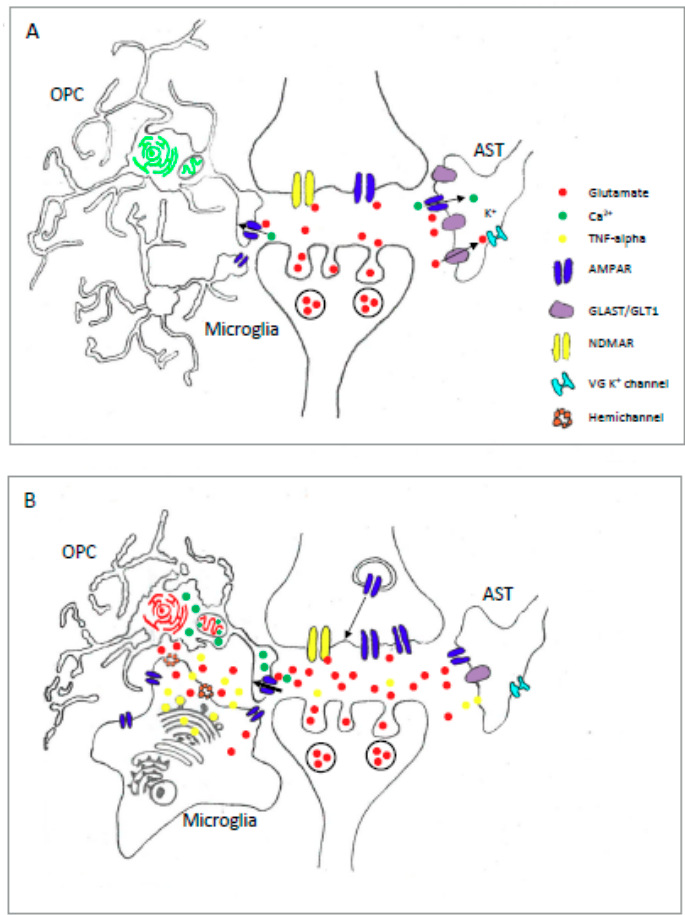
Figure 2. AMPAR functions for peri-synaptic CNS glia in health and disease. ( A ) In the healthy CNS astrocyte (AST) and OPC / NG2-glia processes exhibit physical and functional contacts with neuronal synapses. Ca 2+ permeable AMPAR on Bergmann glia sustain the physical interaction between glial processes and neuronal synapses allowing e ffi cient clearance of glutamate from Purkinje cell synapses. Activation of astrocyte AMPAR also induces a blockade of outward K + currents that may support neuronal function during sustained periods of neuronal activity. OPC / NG2-glia in developing and adult CNS tissues exhibit Ca 2 + permeable AMPAR and receive AMPAR-mediated synaptic input that may regulate their migration, maturation and survival. In the adult CNS NG2-glia continue to receive synaptic input, the functions of which remain unclear. The role of microglial AMPAR in the healthy CNS remain unknown although in vitro data suggest a role in chemotaxis [117]. ( B ) Glial cell AMPAR amplify pathological conditions and mediate glial cell injury in the CNS. Stimulation of AMPAR under excitotoxic conditions induces the release of glutamate from activated microglia via gap-junction hemichannels. AMPAR activation under hypoxic conditions also stimulates the upregulation of microglial AMPAR leading to an imbalance in anti- and pro-inflammatory cytokine release characterised by enhanced release of TNF- α . TNF- α released from activated microglia may intensify excitotoxic conditions by inducing the downregulation of astrocytic GLT1. Similarly, direct stimulation of astrocyte AMPAR may worsen excitotoxic conditions by inducing the downregulation of GLAST. TNF- α also increases the vulnerability of neurons to excitotoxicity by stimulating increased surface tra ffi cking of AMPAR. Excessive AMPAR activation induces direct injury to OPC via numerous mechanisms including oxidative and ER stress and mitochondrial dysfunction (depicted by red organelles). In addition, excitotoxic stimulation of OPC AMPAR alters the function of transcription factor complex NF-Y leading to alterations in the expression of Ca 2 + permeable GluA4 subunits and the regulation of genes involved in